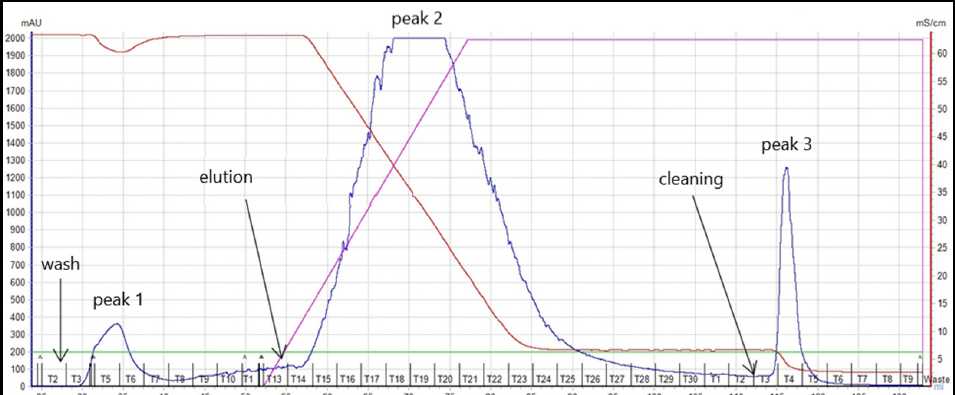
Figure 1. Separation of dialyzed IgY anti-RBD spike SARS-CoV-2 using chromatography system, AKTA START™ on a HiTrap IgY Purification HP column. Flow-through was pool fractions 3–6 (peak 1); eluate was pool fractions 15–24 (peak 2); cleaning or column regeneration (peak 3). Absorbance intensity of protein (mAU), solution conductivity (mS/cm), and solution gradient concentration are shown in blue, red, and purple lines, respectively.